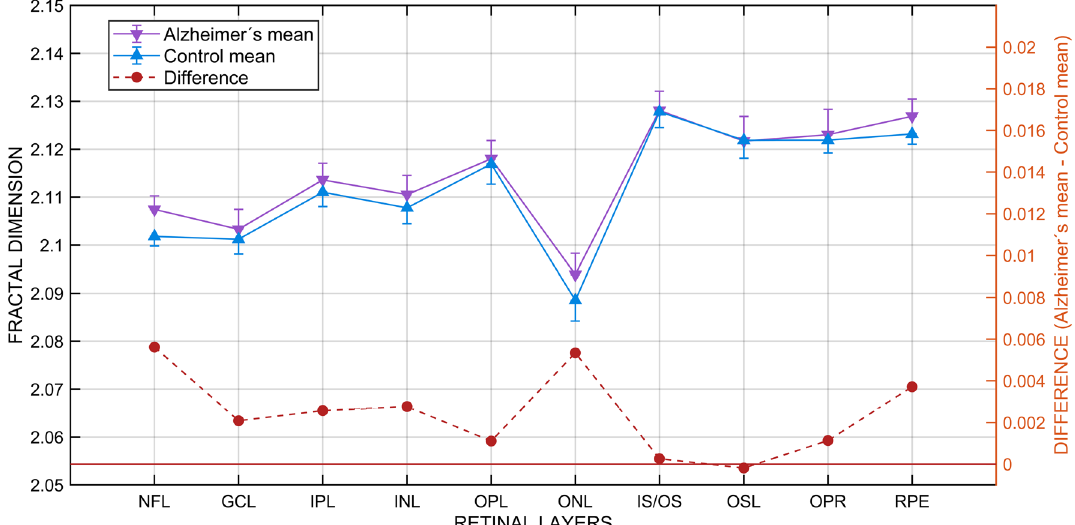
Figure 3. Fractal dimension of retinal layers. Means and standard deviations for each retinal layer in the Alzheimer’s disease and control groups (left axis and continuous lines) and differences between groups (right axis and dashed line). NFL nerve fiber layer, GCL ganglion cell layer, IPL inner plexiform layer, INL inner nuclear layer, OPL outer plexiform layer, ONL outer nuclear layer, IS/OS inner segment/outer segment layer, OSL outer segment layer, OPR outer segment PR/RPE complex, RPE retinal pigment